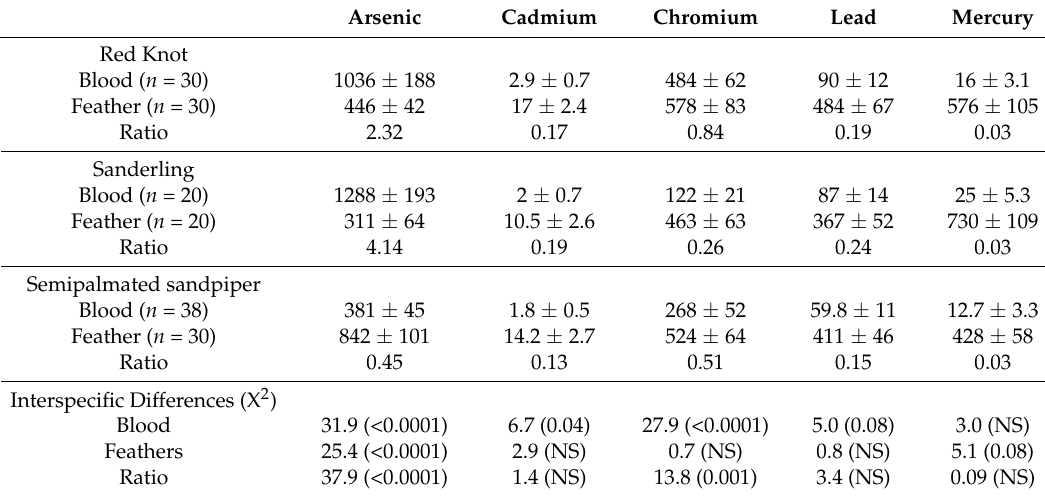
Table 1. Levels of heavy metals (mean ± SE, ppb) in shorebirds collected at Delaware Bay, New Jersey, for blood, feathers, and the ratio of